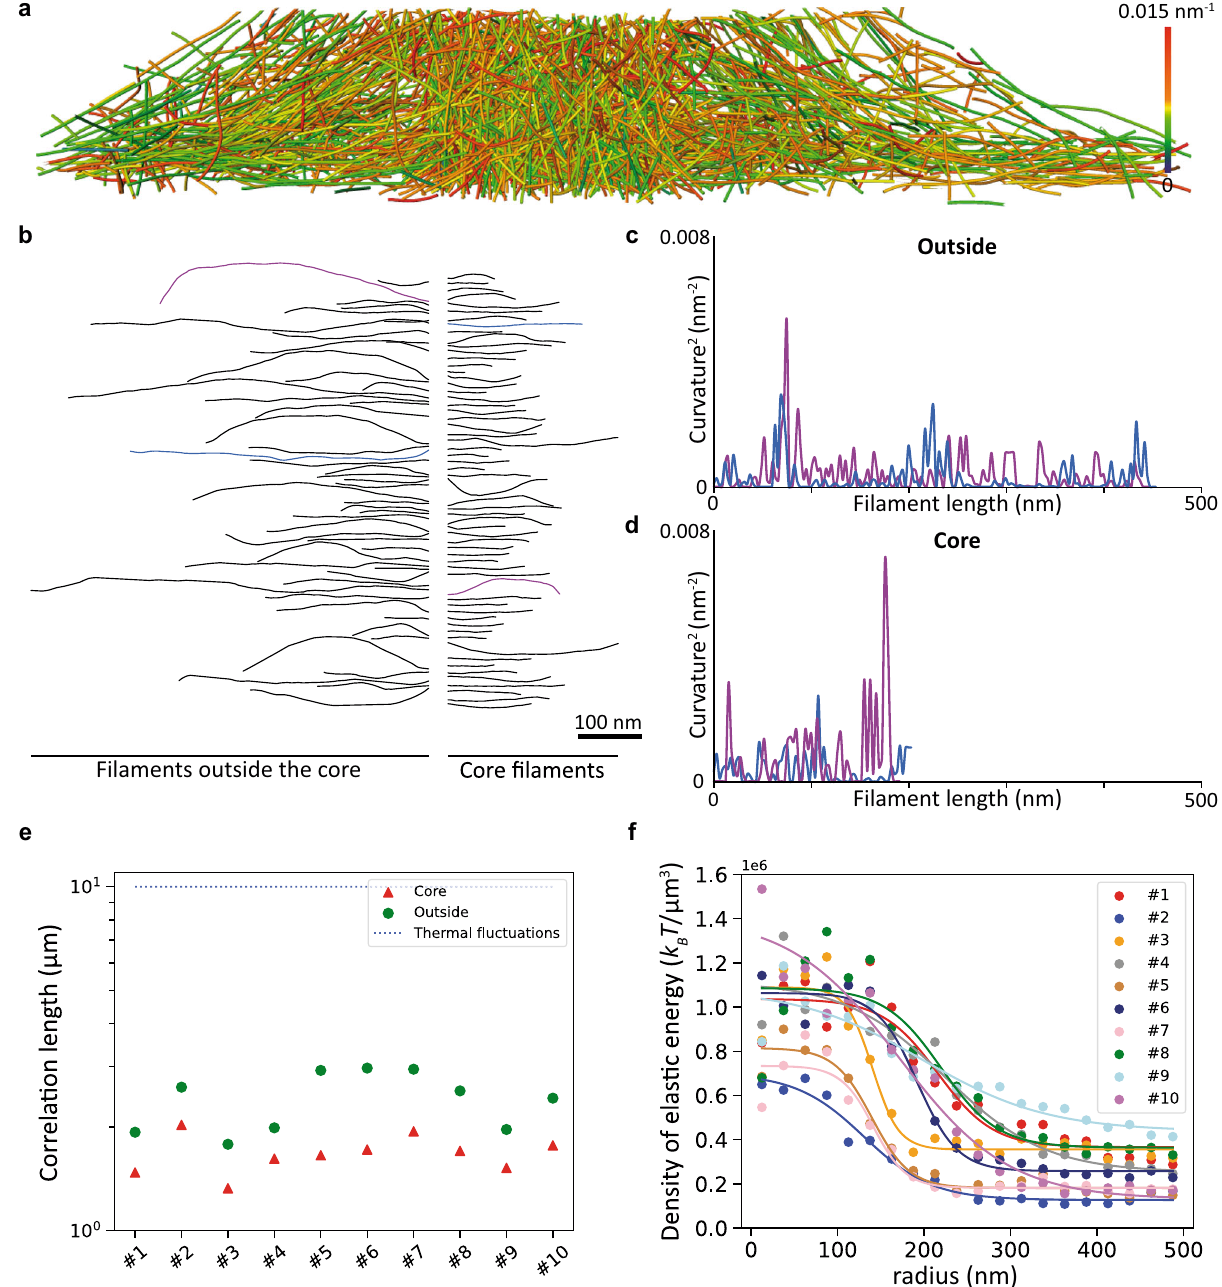
Fig. 3 Podosome fi laments are compressed and store high elastic energy inside the core. a Perspective view of a cross-section through podosome #1 displaying the mean curvature of the fi laments. See also Supplementary Movie 6. The network diameter is 1.56 µ m. The original tomogram has been deposited in the EMDB under accession code EMD-13666. b Gallery of a random selection of actin fi laments from podosome #1. Filaments from the core (right) and outside the core (left) are shown. c , d Square of the local curvature along the fi lament length for the blue and purple fi laments from the galleries of fi laments outside ( c ) and inside ( d ) the core shown in b . e Correlation length in the ten observed podosomes. The correlation length inside the podosome core (1.68 µ m on average) is smaller than outside (2.41 µ m on average). Both values are smaller than those expected from thermal fl uctuations of the fi laments (about 10 µ m 30 ), showing that energy has been spent to compress the fi laments. f Density of elastic energy as a function of the radial distance from the core center for ten tomograms. Source data are provided as Source Data fi integrand represents the square of the local curvature along the fi lament (Methods and Supplementary Fig. 8a). We evaluated the elastic energy per unit volume as the sum of the energies over all fi laments in a given interval at a radial distance r from the core (Supplementary Fig. 8b). The density of elastic energy stored inside where κ ~ 4 * 10 − 26 N.m 2 is the bending modulus 30 , t ( s ) is the the core is much larger than that outside the core, by factors tangent vector as a function of the arc-length coordinate s , and the